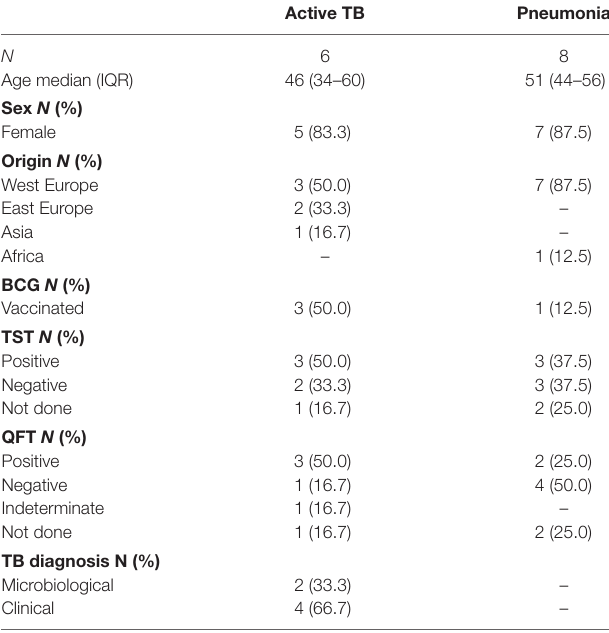
TaBle 3 | Demographical and clinical characteristics of patients evaluated by flow